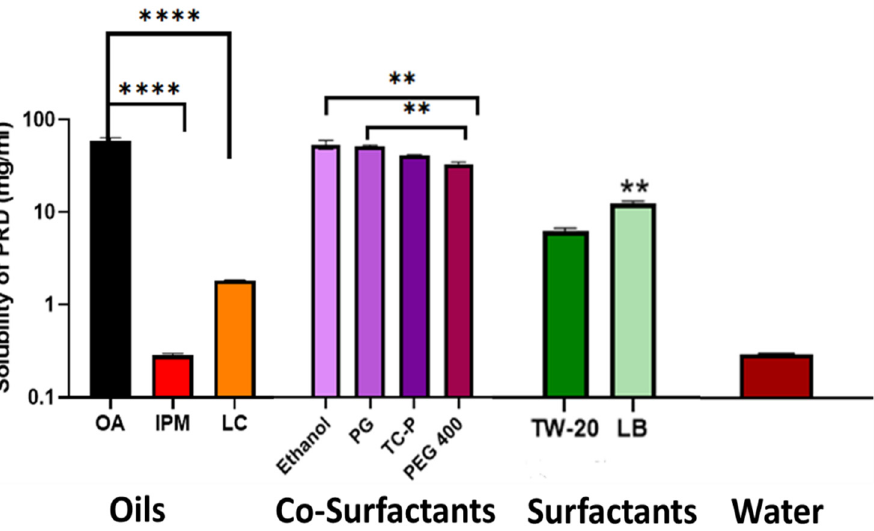
Figure 1. Solubility of PRD in oils (OA: oleic acid; IPM: isopropyl myristate; LC: Labrafac ® CC), surfactants (PG: propylene glycol; TC-P: Transcutol ® P; PEG 400: polyethylene glycol), cosurfactants (TW-20: Tween ® 20; LB: Labrasol ® ), and water. Data are presented as mean ± SD ( n = 4). Significant results are marked with asterisks with p < 0.01 is given two asterisks and p < 0.0001 is given four asterisks.